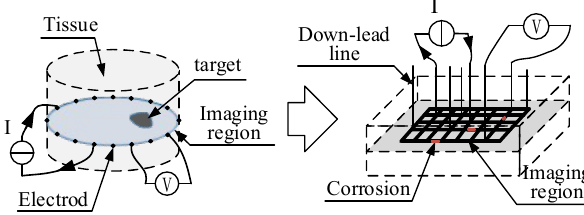
Figure 1. The physical model of medical EIT and grounding grid EIT.